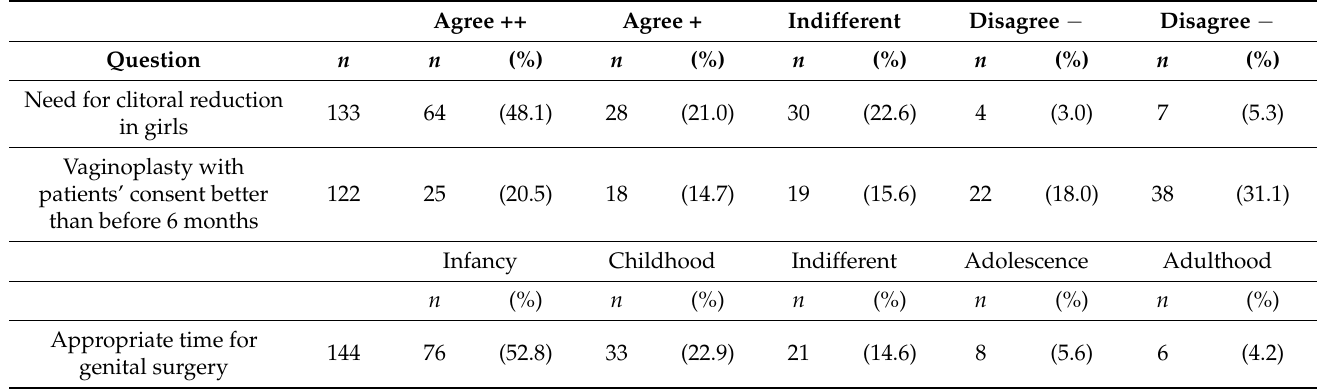
Table 7. Questions concerning need and timing of feminizing surgery in women with